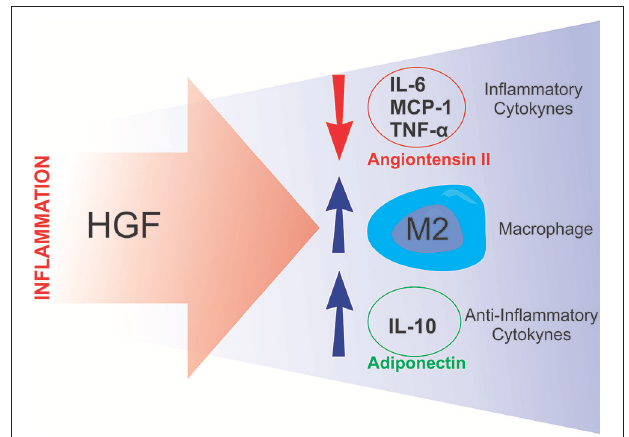
FIGURE 4 | Putative compensatory role of HGF. During the inflammatory process, HGF seems to attenuate inflammation by inducing anti-inflammatory responses such as: downregulating angiotensin II activity and inflammatory cytokine synthesis, and stimulating M2 macrophage polarization and anti-inflammatory cytokine